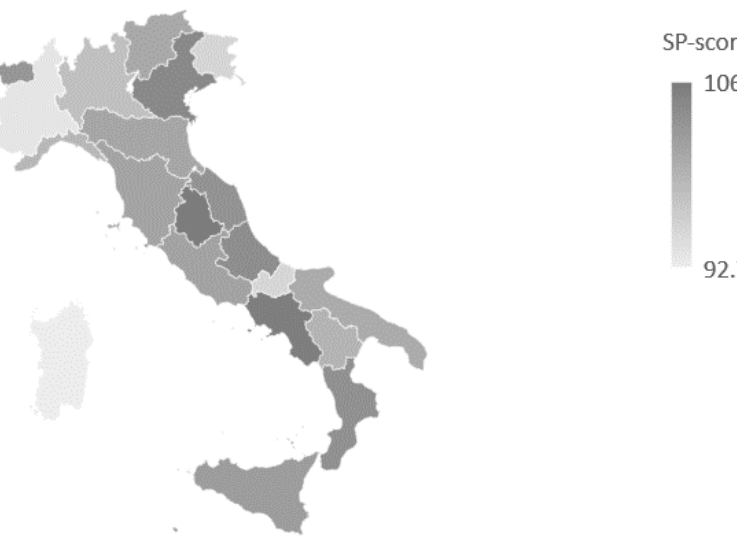
Figure 1. SP-score—Innovative start-ups. Map of Italian Figure 1. SP-score — Innovative start-ups. Map of Italian regions.